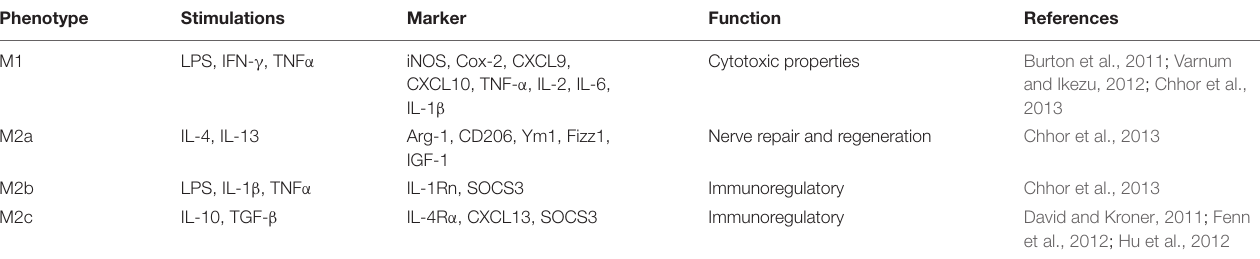
TABLE 1 | Stimulations, markers, and functions of different subtypes of